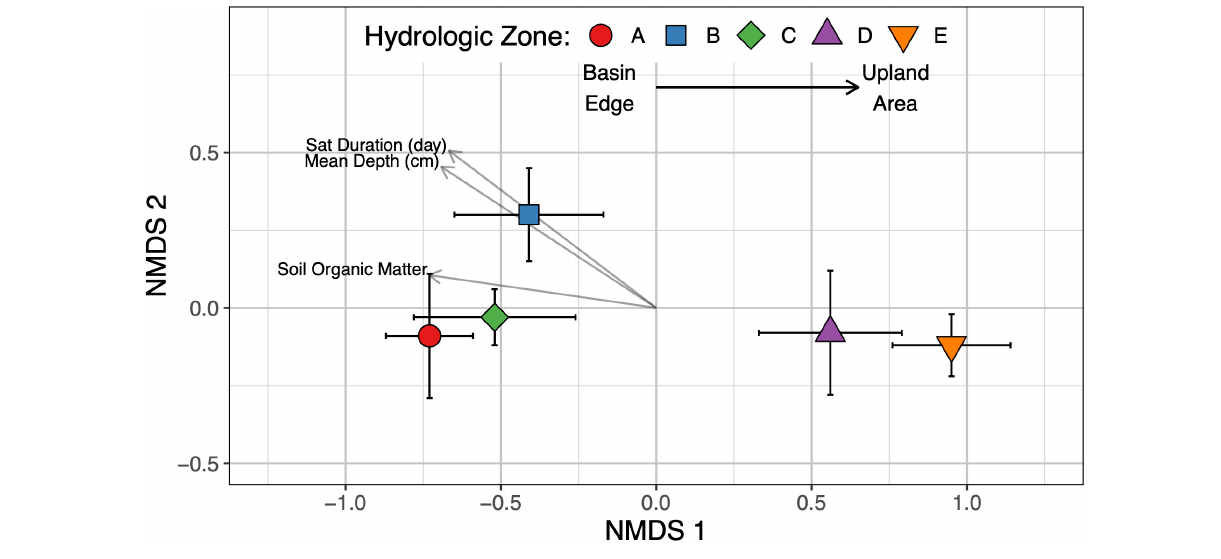
FIGURE 3 | Non-metric multidimensional scaling plot showing separation of the soil microbiome based on Bray-Curtis dissimilarities. Environmental variables significantly correlating with the ordination space are included as vectors in the ordination plot (alpha =